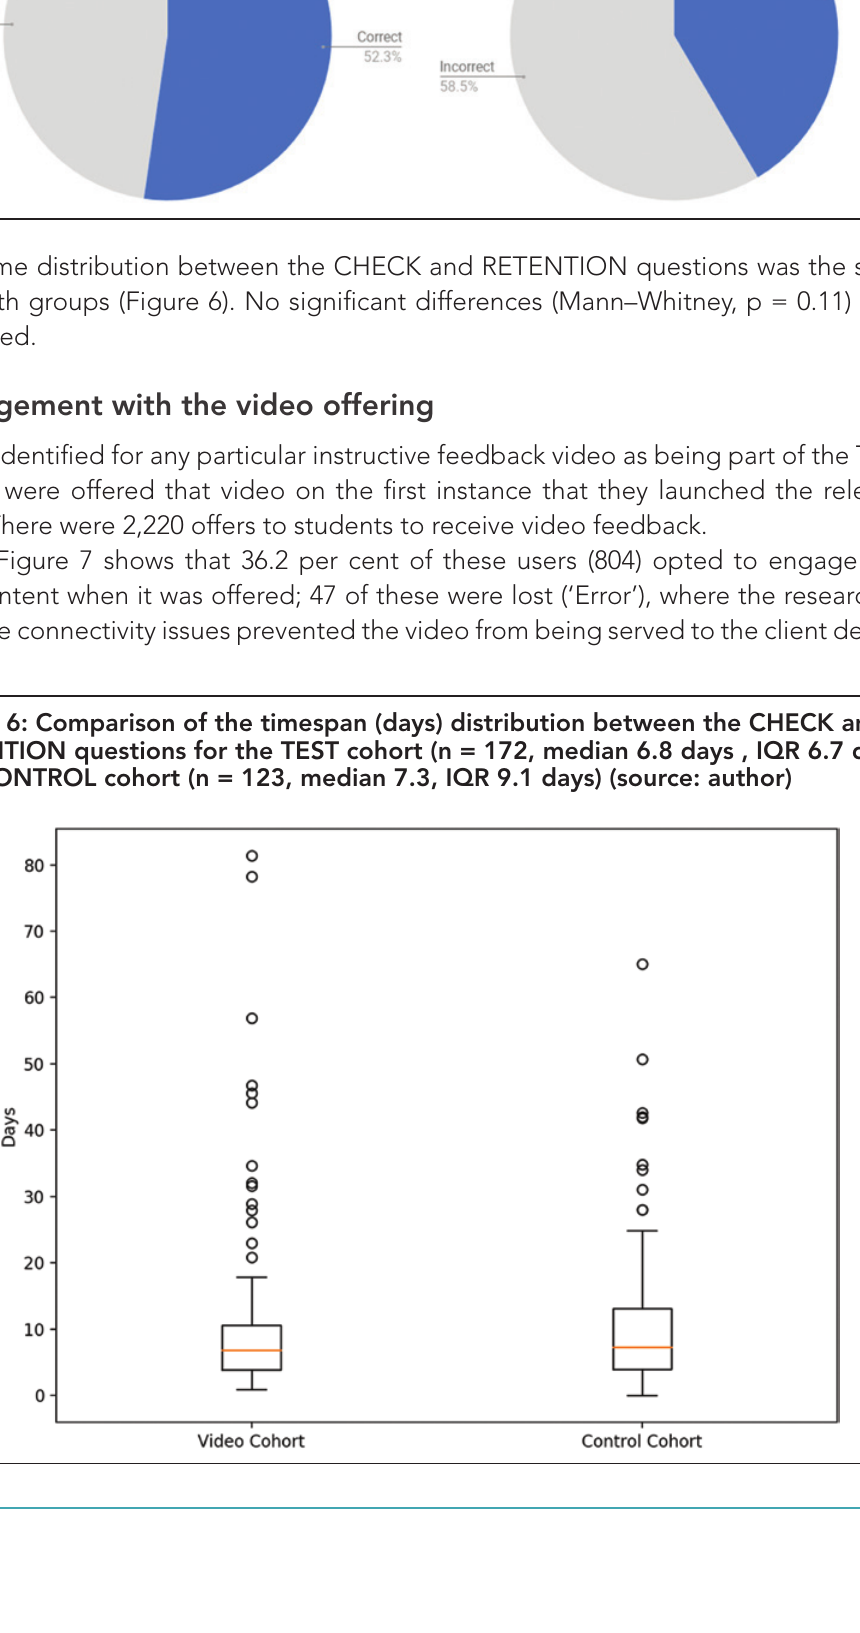
figure 5a: answer distributions for the ReTeNTIoN question (after passing the checK question) for the TesT (n = 172, 52.3% correct) cohort; figure 4b: answer distributions for the ReTeNTIoN question (after passing the checK question) for the coNTRol cohort (n = 123, 41.5% correct) (source: author)